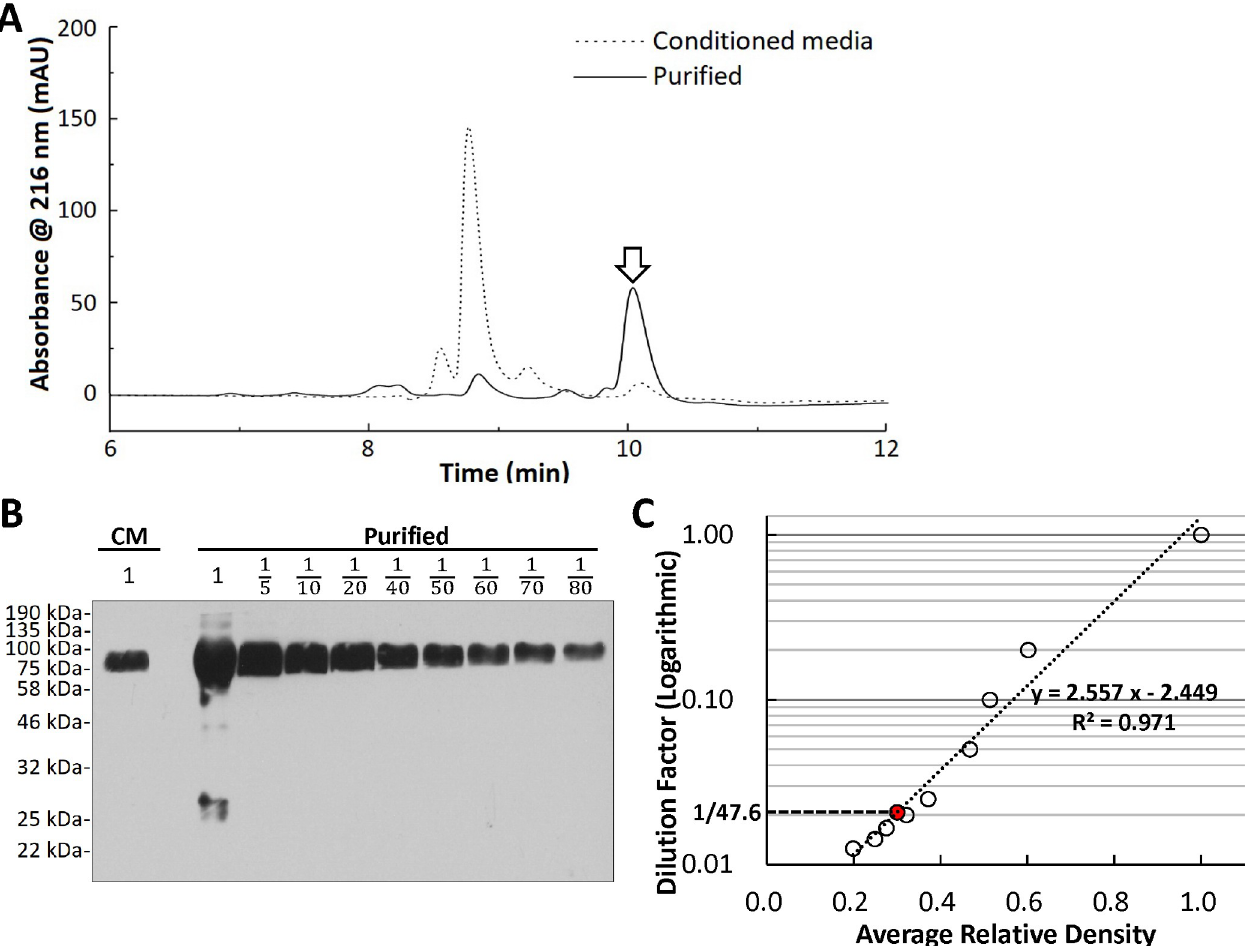
Fig 4. Fusion protein MICA-G129R purification from conditioned media. Nickel resin chromatography was used to purify the fusion protein MICA-G129R from conditioned media. A. HPLC analysis of the MICA-G129R conditioned media and the purified MICA-G129R protein solution. The white arrow indicates the peaks of MICA-G129R protein. B. Fusion protein MICA-G129R in the conditioned media and serial dilutions of the purified protein were detected using anti-MICA antibody in Western blot. The purified protein was diluted with fresh culture media of 293. CM indicates the lane loaded with the conditioned media before purification. The numbers on the lanes indicate the dilution factors. There is an empty lane between the lane of conditioned media and the lanes of the purified protein dilutions. C. Quantification of the Western blot in ( B ). All the bands were quantified based on the average relative densities using ImageJ. The serial dilutions of the purified MICA-G129R protein solution were quantified and modeled by a regression line logarithmically. The red dot shows where the original MICA-G129R conditioned media is on the regression line based on its average relative density.